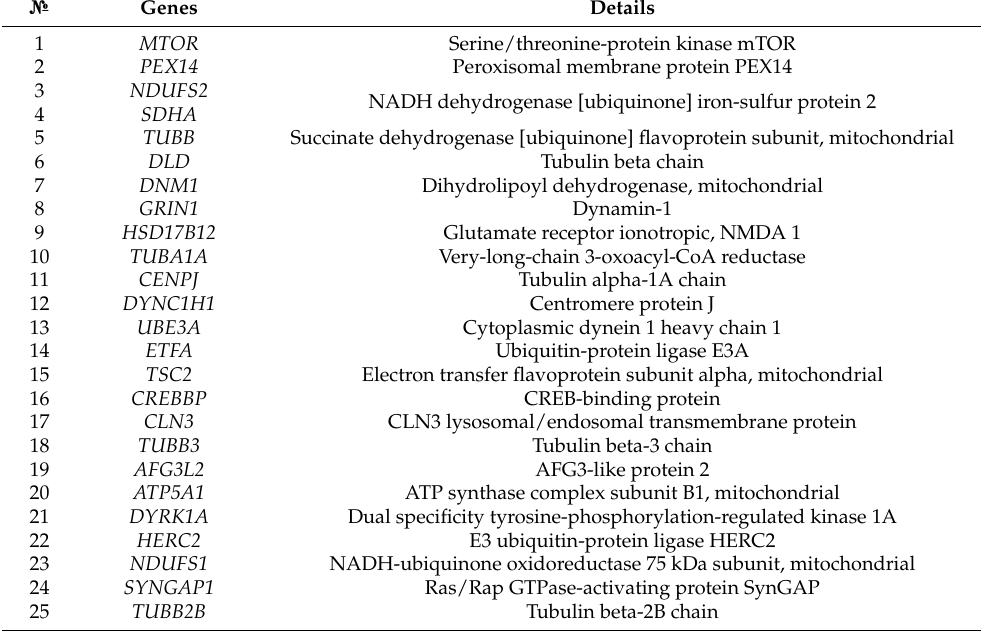
Table 2. Functional analyses of the identified ‘hub’